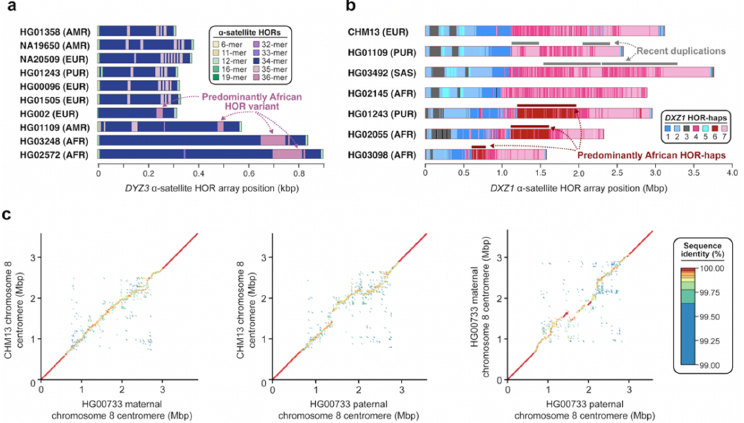
Figure 5. Sequence and structural variation within centromeric α-satellite HOR arrays. ( a ) Plots showing the structure of the chromosome Y DYZ3 α-satellite HOR array in ten diverse human genomes, highlighting the presence of a 36-mer α-satellite HOR variant in four haplotypes (HG002, HG01109, HG03248, and HG02572) [76]. ( b ) Plots showing the α-satellite HOR haplotypes (HOR-haps) present in the chromosome X DXZ2 α-satellite HOR array in seven diverse human genomes. Two genomes (HG01109 and HG03492) harbor a haplotype with a recent duplication, while three others (HG01243, HG02055, and HG03098) harbor a haplotype that is especially prevalent among those with African ancestry. Adapted from [44]. ( c ) Plots showing the pairwise sequence identity between chromosome 8 centromeric regions from three human haplotypes (CHM13 and two haplotypes from HG00733). The D8Z2 α-satellite HOR array shows variation in sequence and structure, while the flanking sequences do not. Adapted from [42].